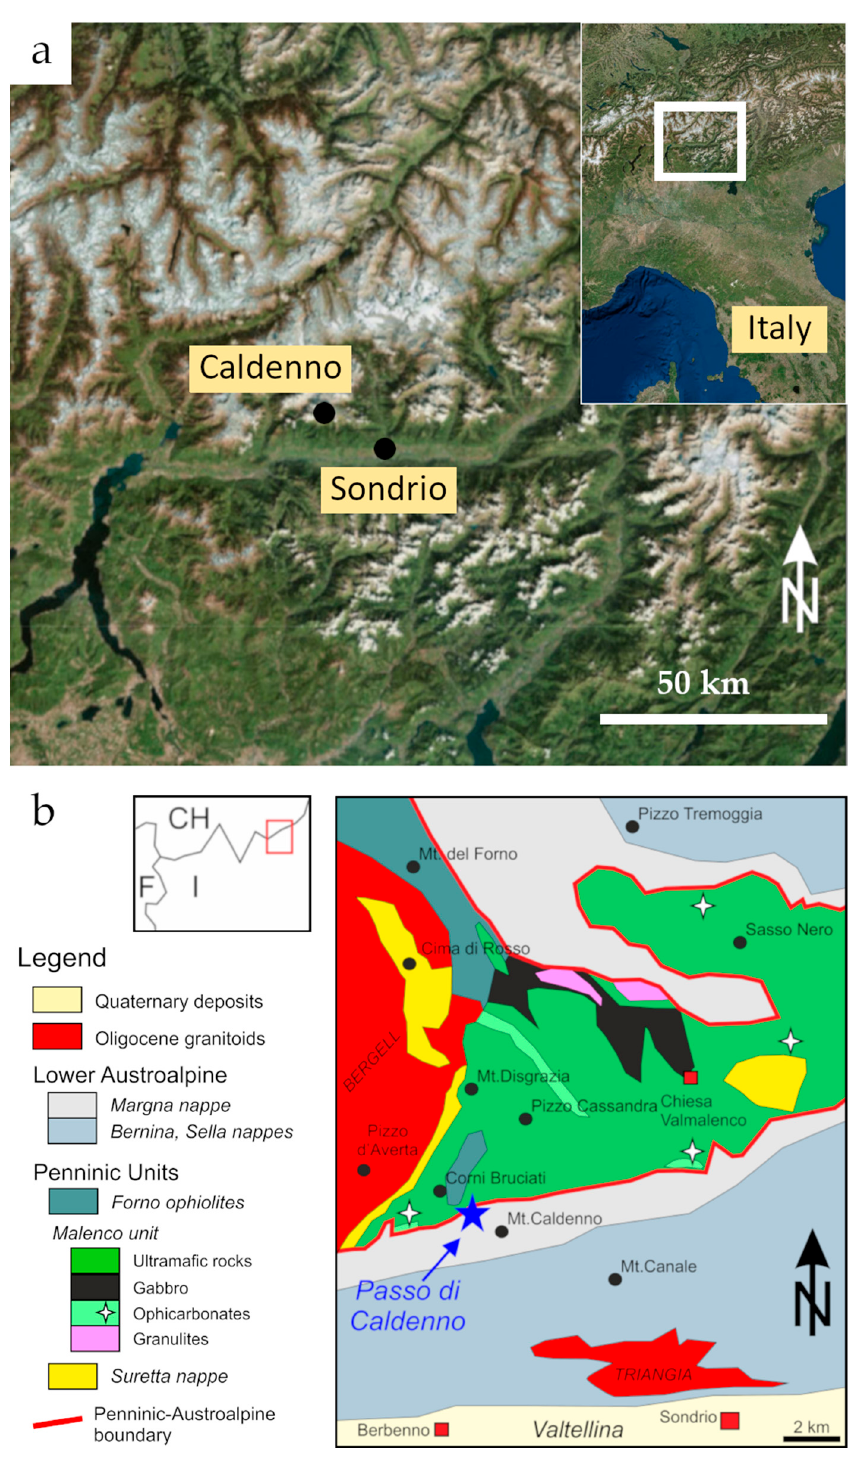
Figure 1. ( a ) Map of area of study (Sources: Esri; DigitalGlobe, GeoEye, Earthstar Geographics, CNES/Airbus DS, USDA, USGS, AeroGRID, IGN, and the GIS User Community). ( b ) Schematic geological map of study area. Red rectangle in the upper left inset indicates the area shown in the geological map at right. Sampling locality of Passo di Caldenno shown as blue star, redrawn after [17,18].